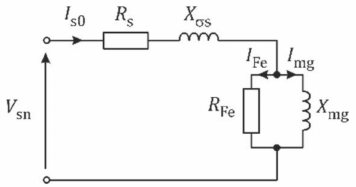
Figure 1. Circuit model of the RIM in the idle